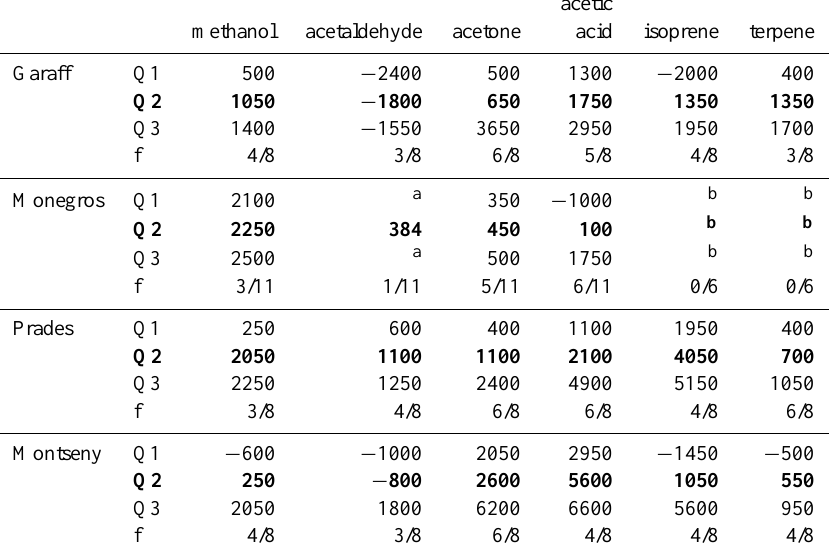
Table 1. Daytime (09:00–17:00LT) fluxes of several VOCs estimated from the gradient technique (µgm − 2 h − 1 ). Negative values indicate deposition to the surface; positive values indicate emission from the surface. Quarters Q1 and Q3 are the limits of interquartile ranges of the estimates from the gradients (Q2 is the median value). The fraction of the measured profiles that provided an acceptable logarithmic curve fit ( r 2 >0.5) and were subsequently used in the gradient flux calculation is shown (Q2 is the median value, bold).